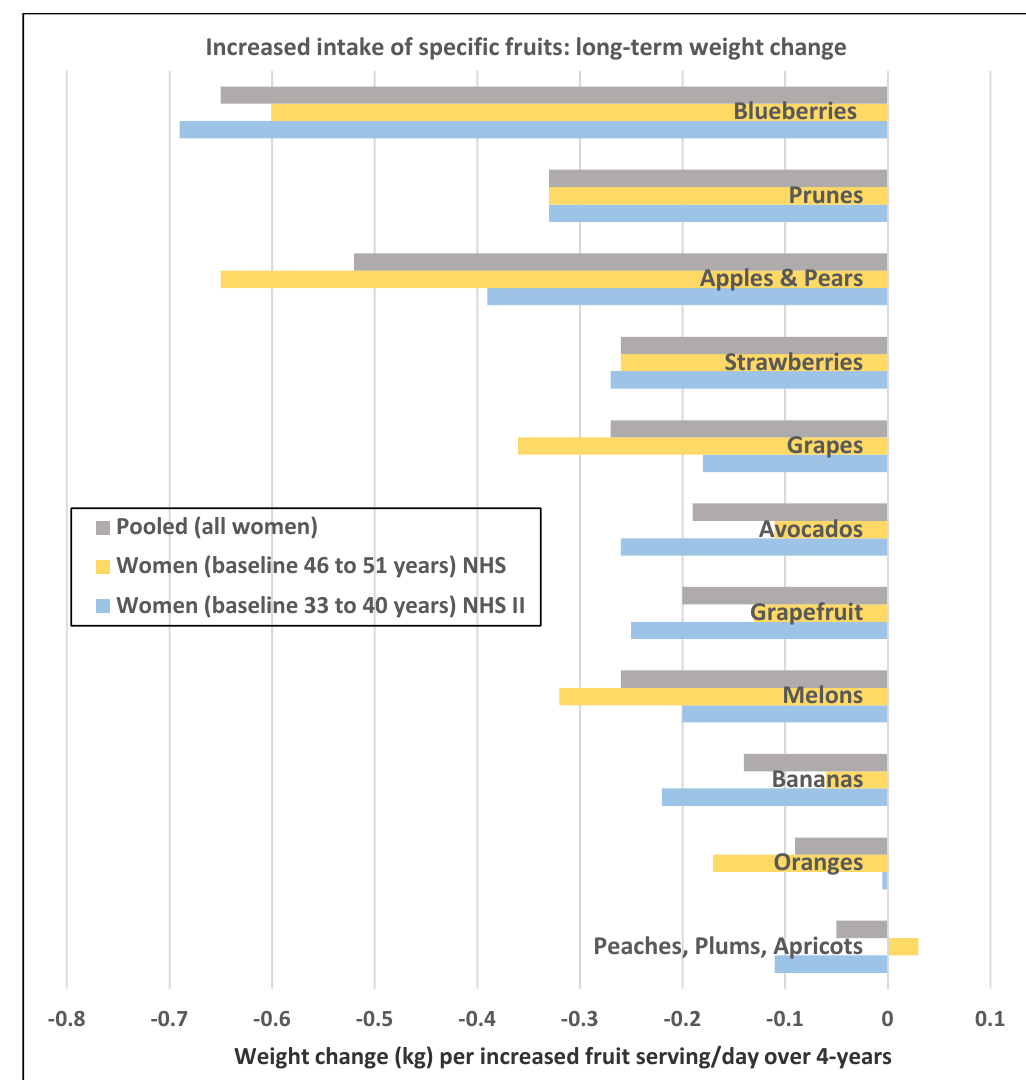
Figure 1. Multivariate adjusted associations from the Nurses’ Health Studies (NHS) per increased serving/day of specific fruits and 4-year weight change (kg) in women of different ages (e.g., premenopausal vs. postmenopausal) [18].